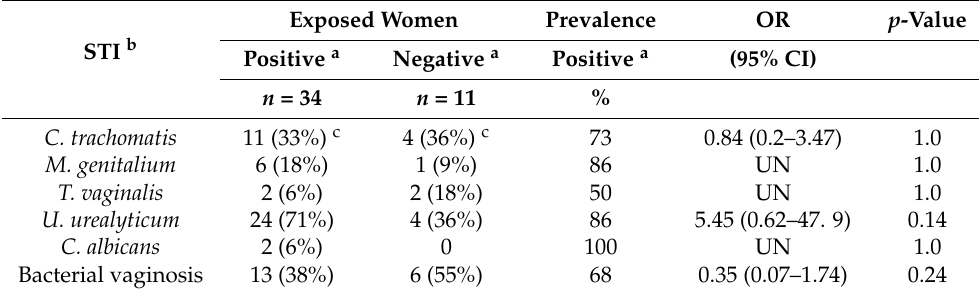
Table 5. Co-infections diagnosed in exposed women and prevalence of Neisseria gonorrhoeae culture- positivity among exposed women. Exposed Women Prevalence OR p STI b